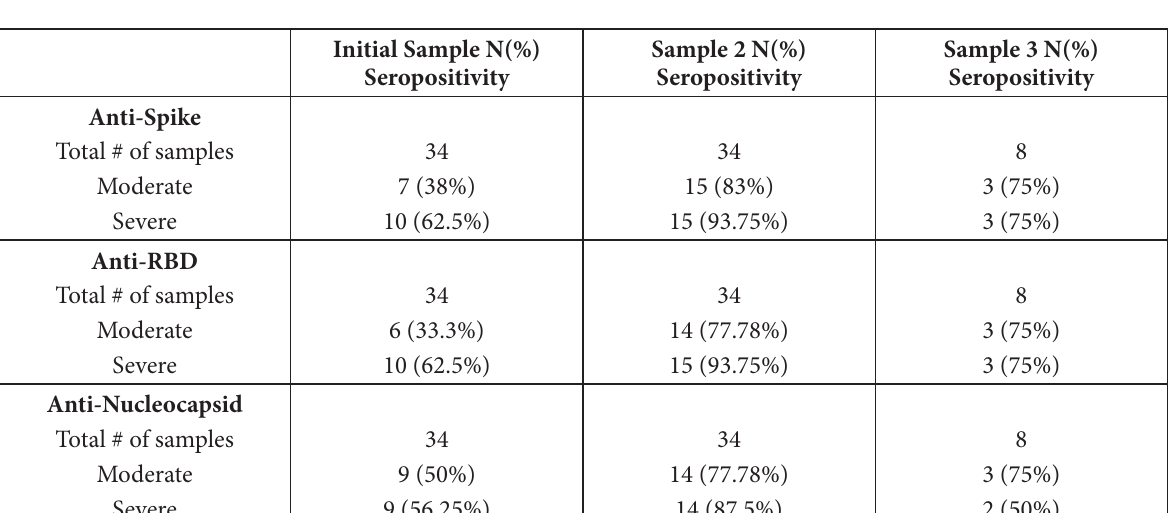
Table 3. Longitudinal Quantitative Antibody Data on a Subset of PCR-positive Moderate and Severe Disease Cohort